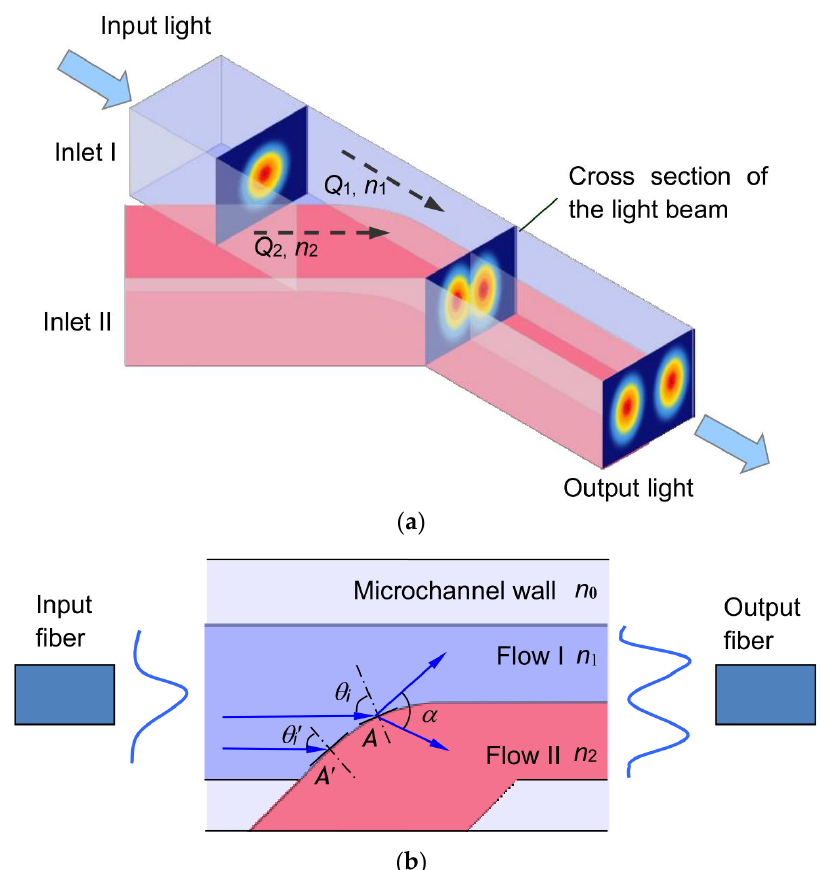
Figure 1. ( a ) Schematic of the optofluidic splitter in a microchannel. ( b ) Close-up of the intersection of two flows.